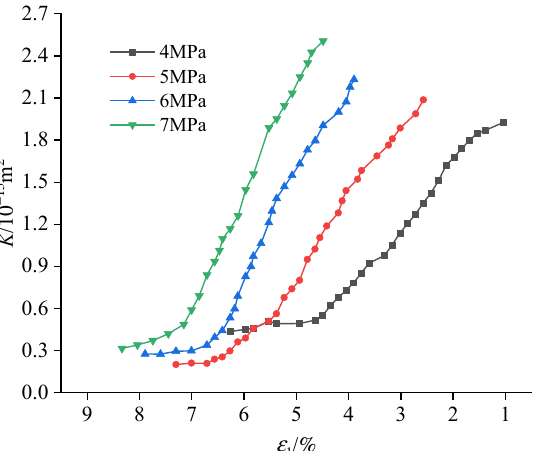
σ σ= = 4 MPa; ( b ) 2 3 2